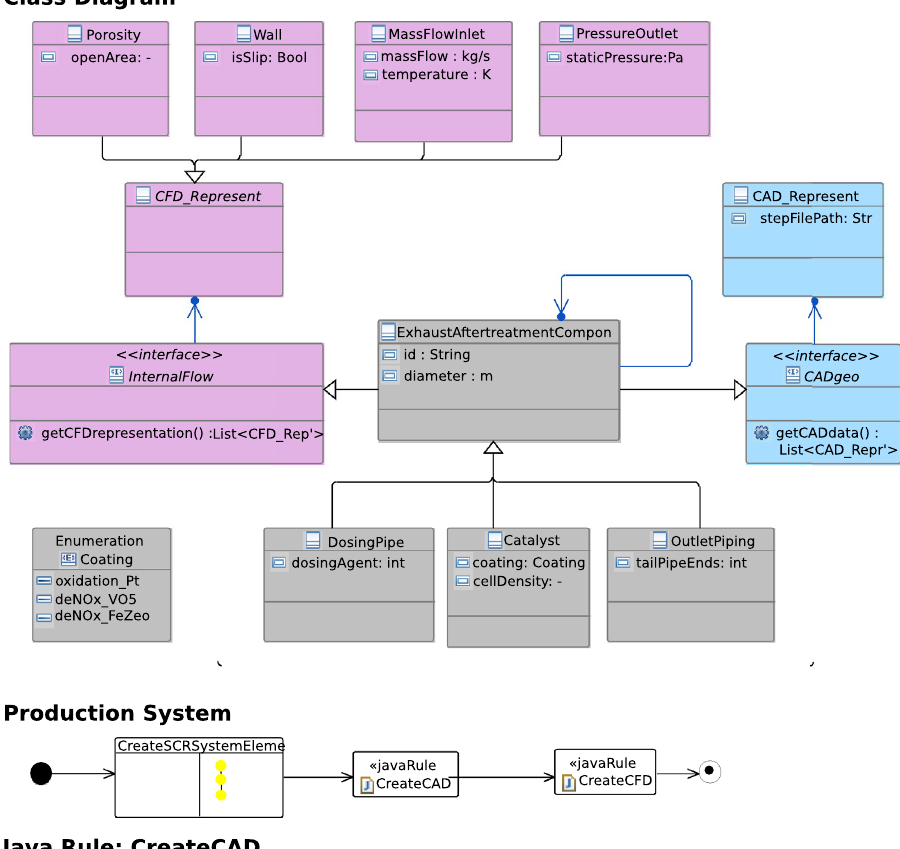
Fig. 14 Case study: Simplified graph-based design lan- guage to create the CAD and CFD model of a SCR exhaust aftertreatment system. The schematically shown approach follows the newly proposed’ design languages style using class methods and